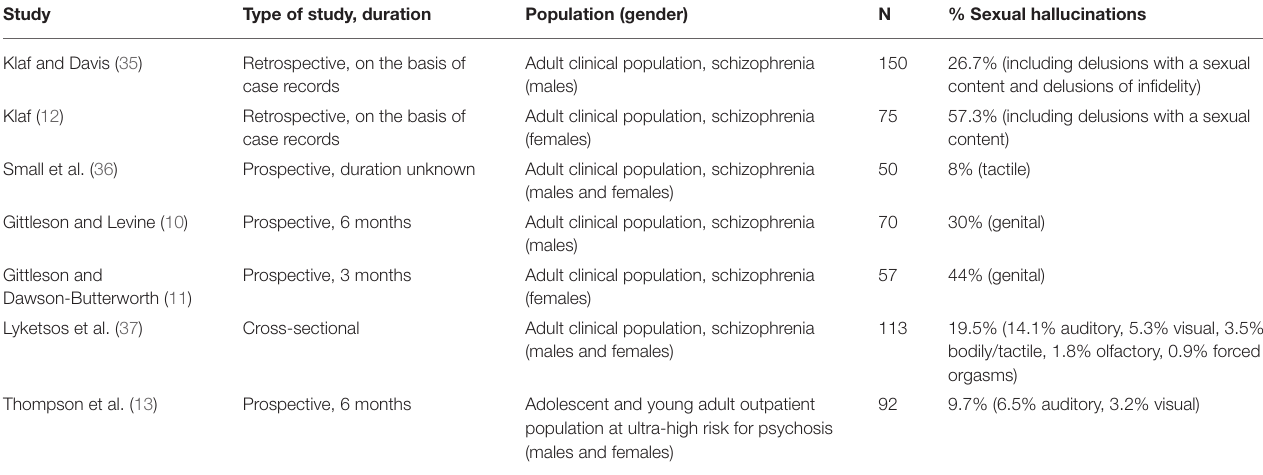
TABLE 3 | Prevalence rates of sexual hallucinations as reported in earlier